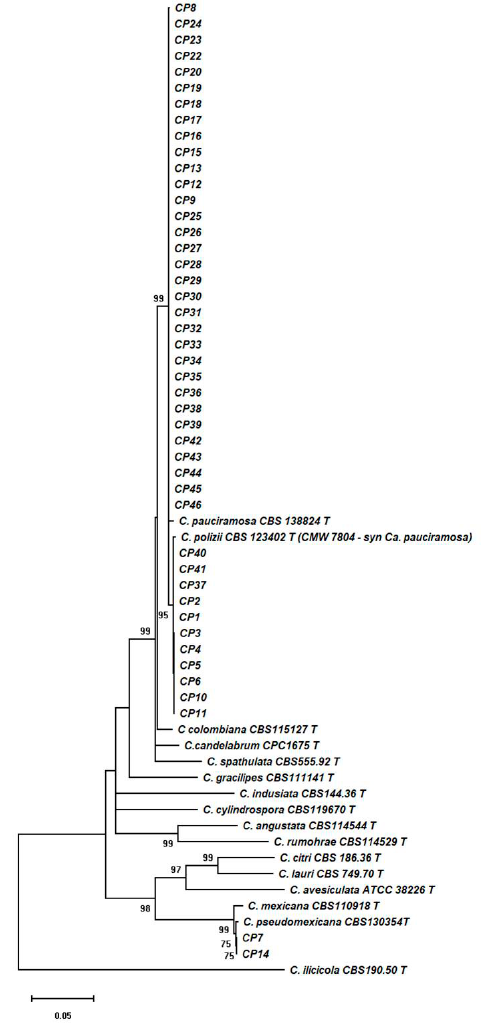
Figure 1. Multilocus (benA, TEF-1 α and HIS-3) phylogenetic tree with the highest log likelihood ( − 7299.13) is shown. Numbers above branches are bootstrap values. Only values >70 % are indicated. CP acronym indicates Calonectria isolates collected and used for this study.